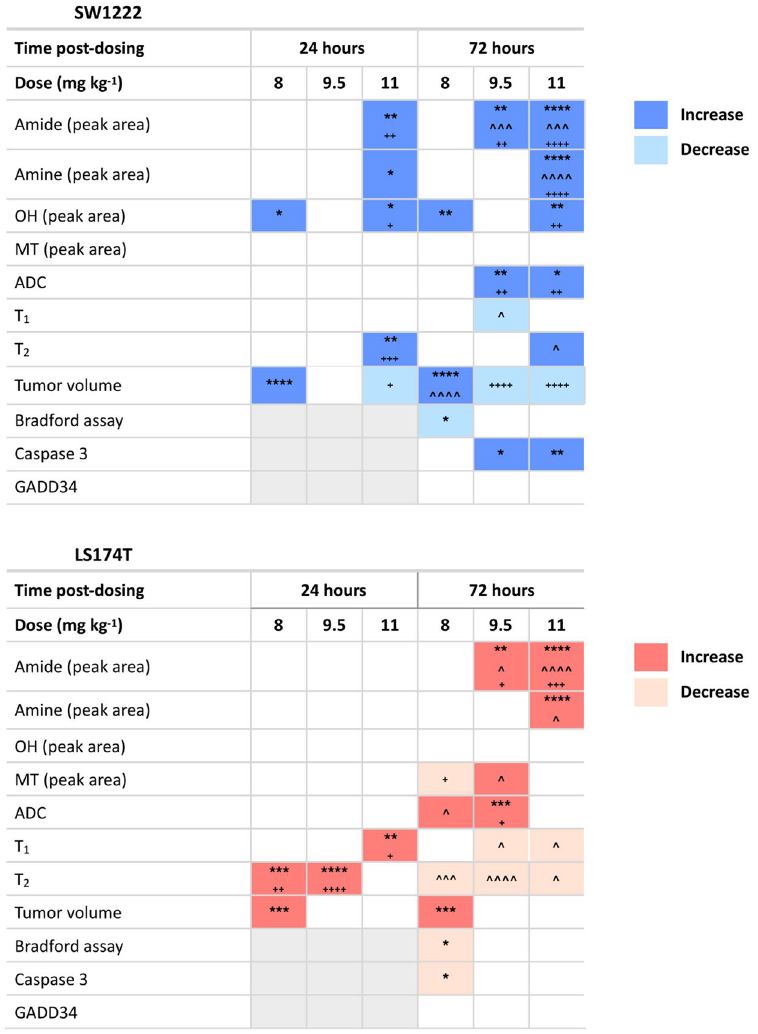
Figure 5. Summary of significant changes (P < 0.05) in each quantitative parameter measured, relative to controls. Dark blue or red cells indicate a significant increase, light blue or red cells indicate a significant decrease, white cells no significant change, and grey cells show where no data were available. * P < 0.05, ** P < 0.01, *** P < 0.001, **** P < 0.0001 (two-way ANOVA); * compared to baseline, ^ compared to measurement at 24 hours post-Ixazomib dose, + compared to